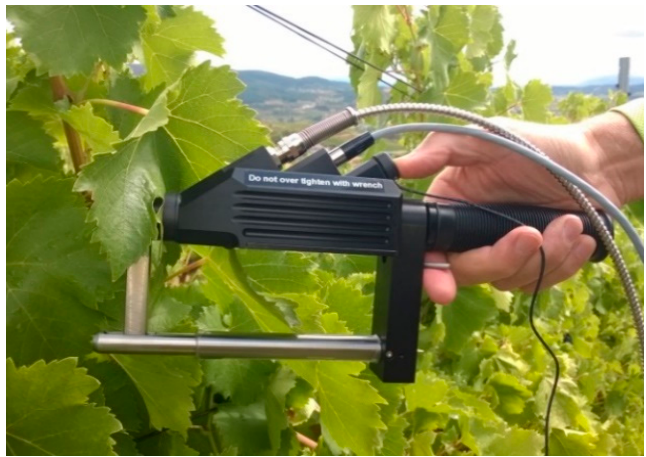
Figure 4. Spectral data collection using a plant probe and leaf clip accessories.